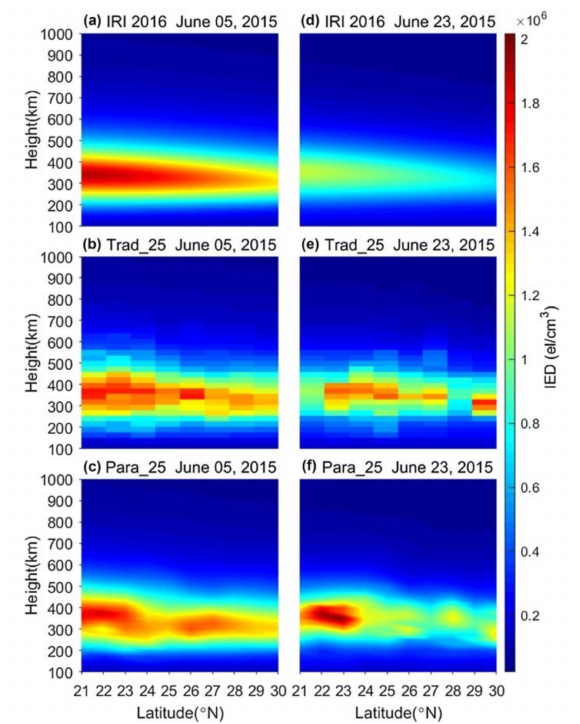
Figure 6. Ionospheric tomography results at 05:30 UT (14:30 JST) on 17 March 2016 (from [32]). ( a ) Latitude-altitude image at 136 ◦ E longitude plane, ( b ) longitude-altitude image at 35 ◦ N latitude plane, ( c ) horizontal distribution at an altitude of 350 km, and ( d ) vertical profile at a location 35 ◦ N, 136 ◦ E.